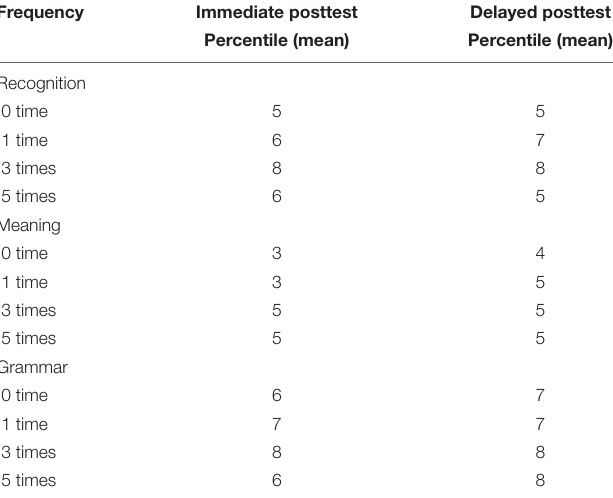
TABLE 8 | Percentiles for